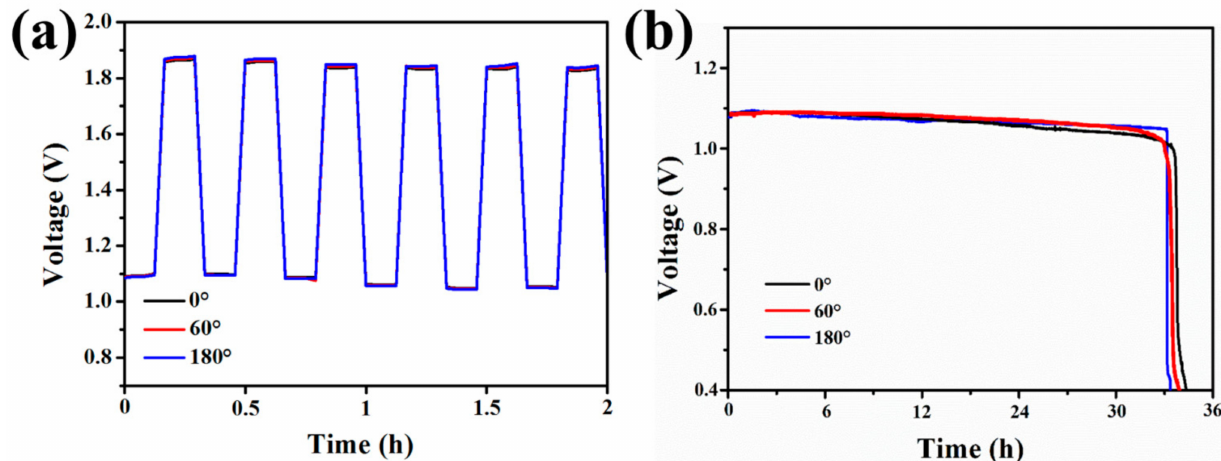
Figure 7. The flexible performance of ZAB battery. ( a ) Constant current charging and discharging cycles under different bending angles of the battery. ( b ) Battery discharge voltage performance under different bending angles.